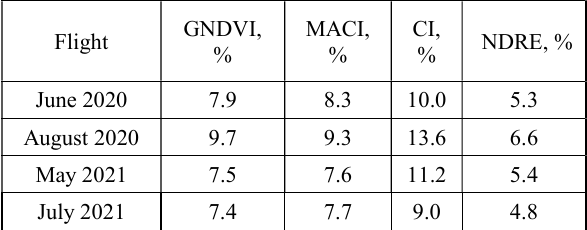
Table 3. The differences between groups Control and Bent